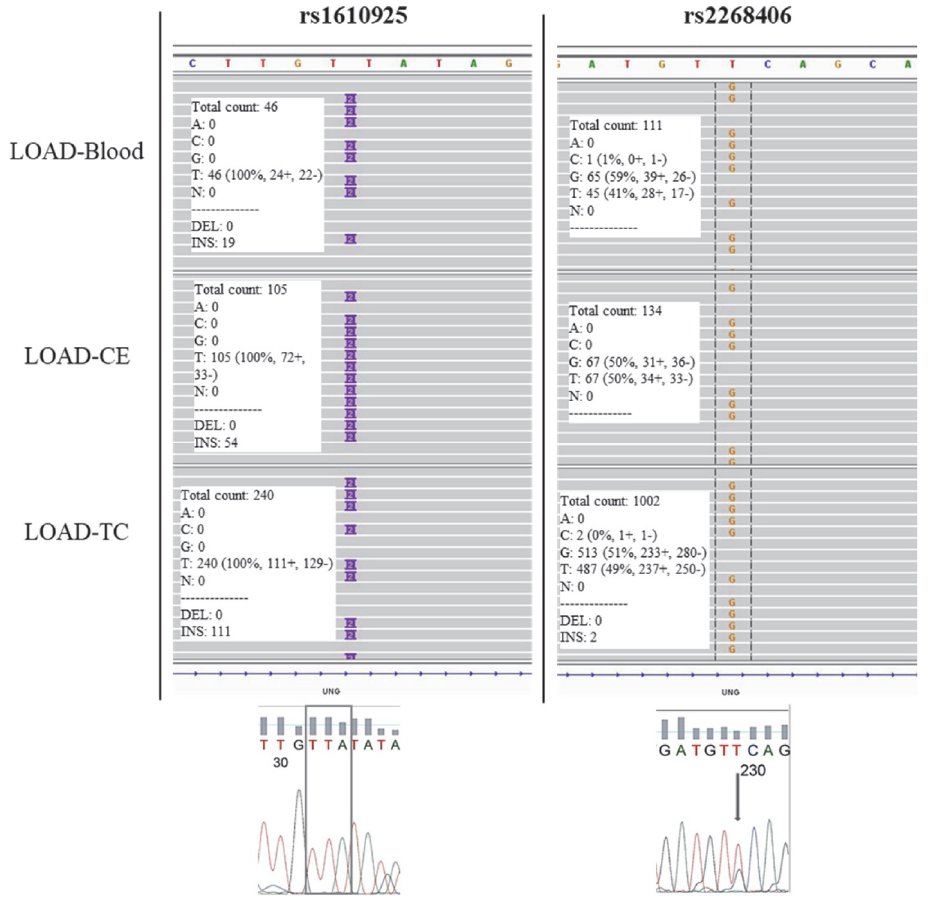
Fig 1. The distribution of genetic variants identified from NGS analysis in each sample. (A) The venn diagram showing the number of genetic variants in LOAD patients and hpC specific to or shared between the blood, TC and CE. (B) Pie charts showing the percent distribution of UNG , NEIL1 , POL β and APOE gene variants in each sample. LOAD, late-onset Alzheimer‘s disease; CE, cerebellum; TC, temporal cortex; hpC, high-pathology control.